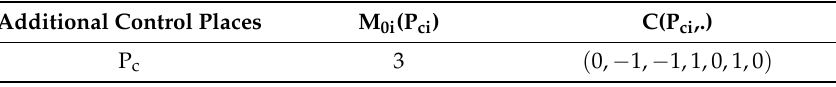
Table 12. PN controllers of Example